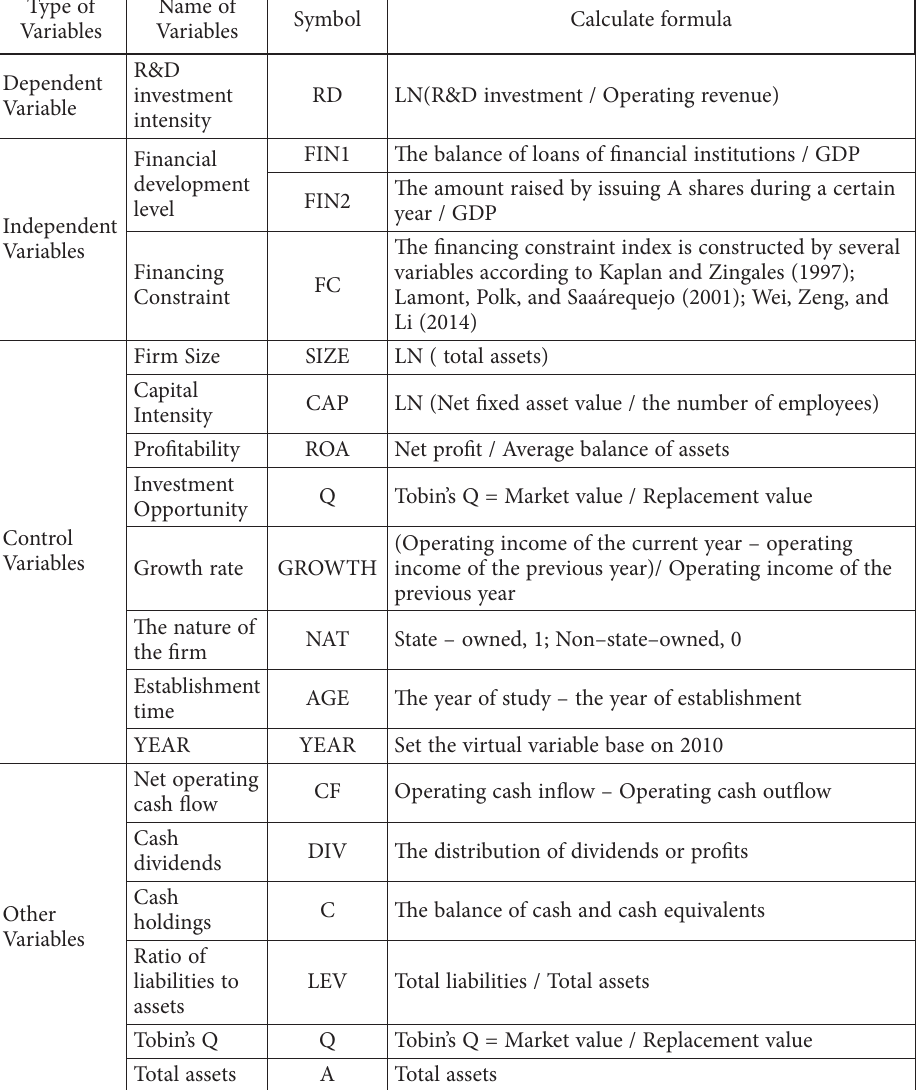
Table 3. Variable definition and calculation